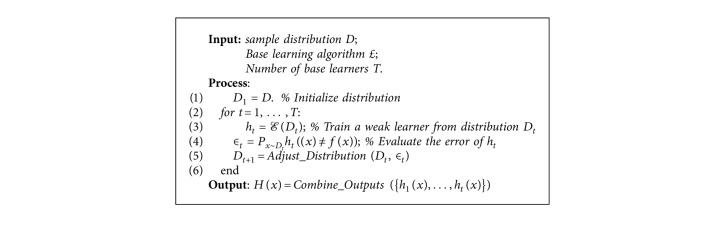
 Boosting algorithm.